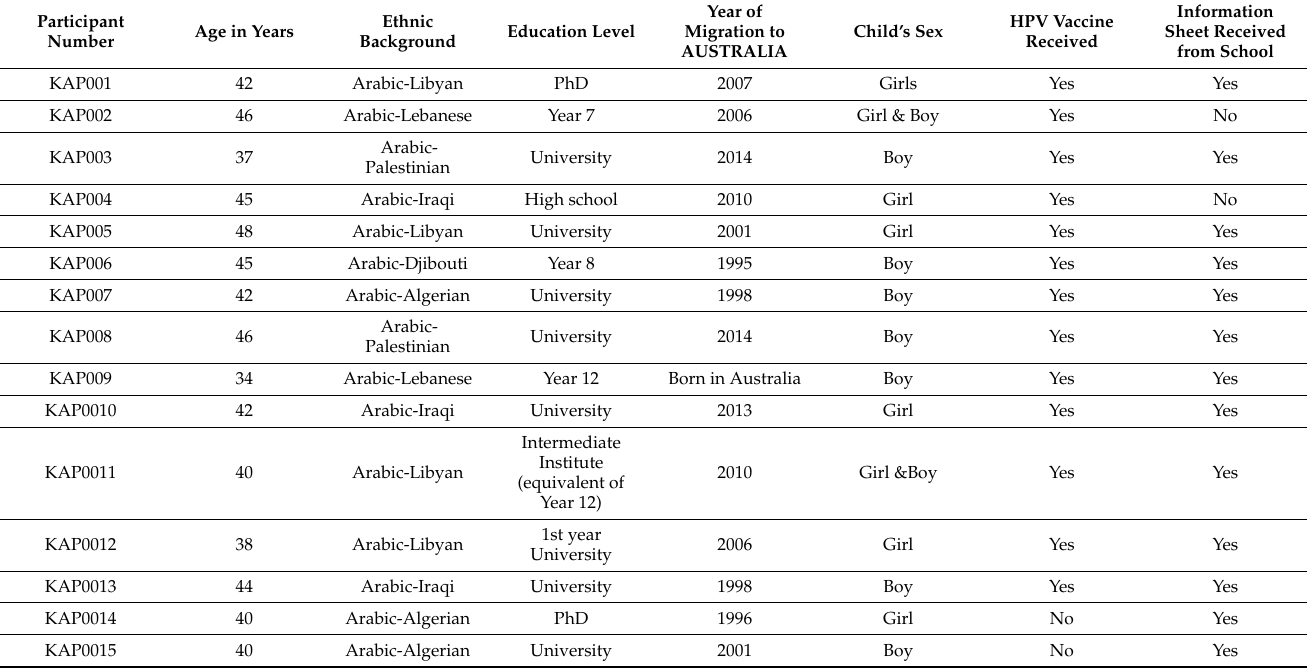
Table 1. Demographics of study